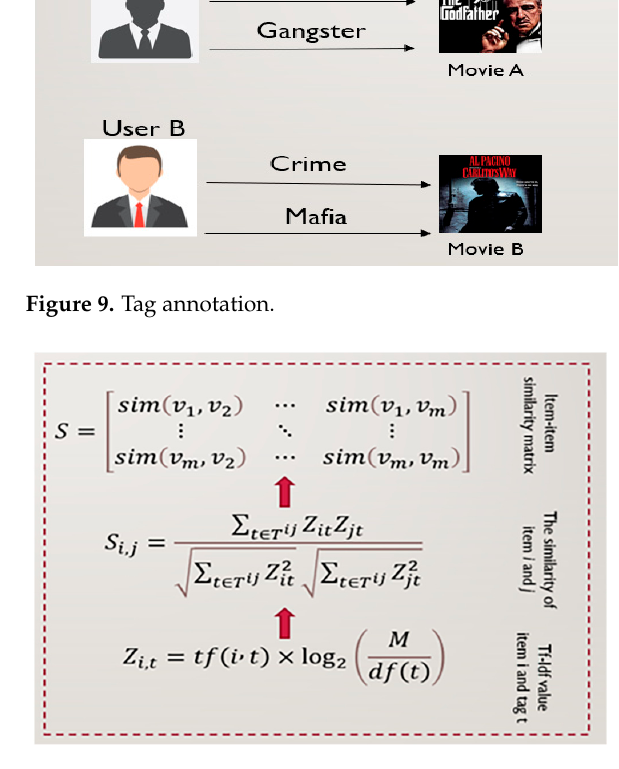
Figure 10. Tag processing part.